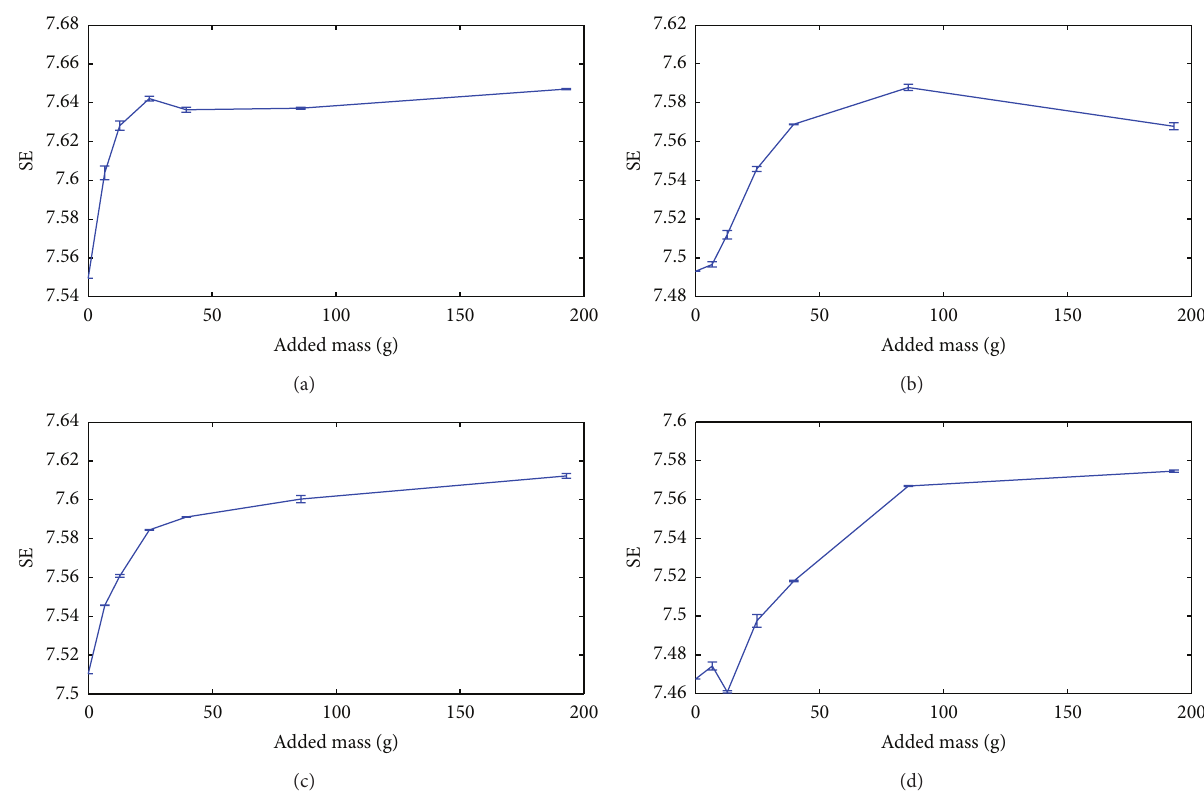
Figure 6: Variation of SE with the added mass in position 1 for: (a) Sensor S1; (b) Sensor S2; (c) Sensor S3; (d) Sensor S4.